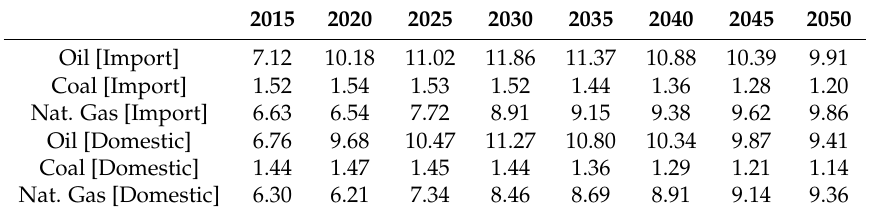
Table A3. Fossil Fuel Cost in M e /PJ, based on SENER [21], International Energy Agency [29].